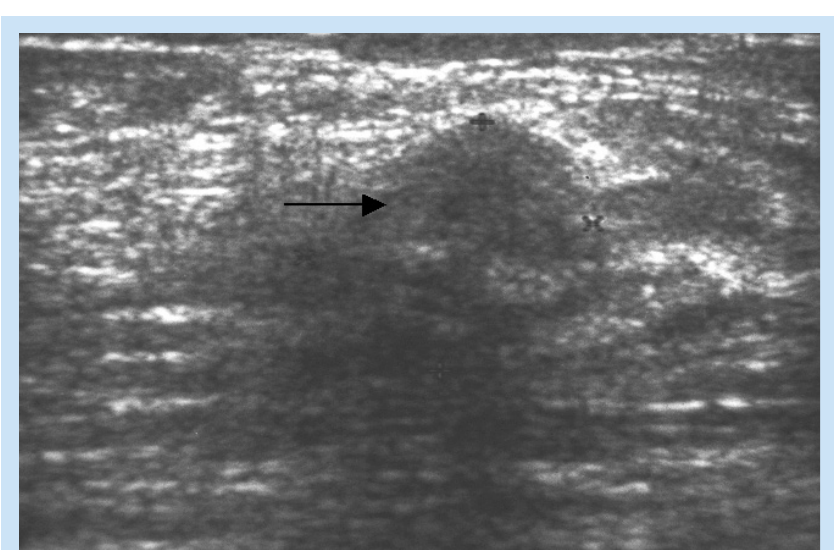
Fig.2c.Ultrasound of the left breast demonstrates a 3 cm diameter hyperechoic mass (arrow) that was confirmed to be fibrous matopathy on biopsy.